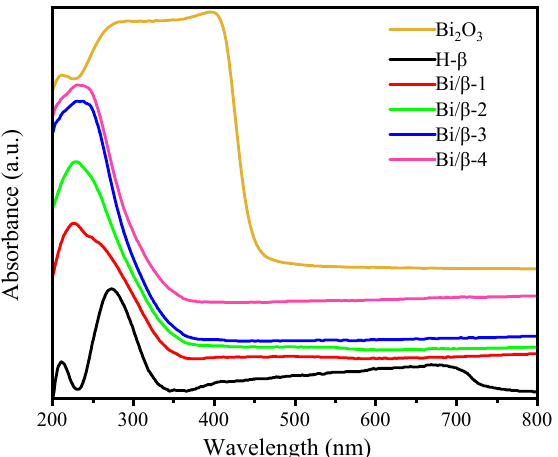
Figure 4. UV-Vis absorption spectra of Bi 2 O 3 , H- β , and Bi/ β catalysts with different Bi loading.